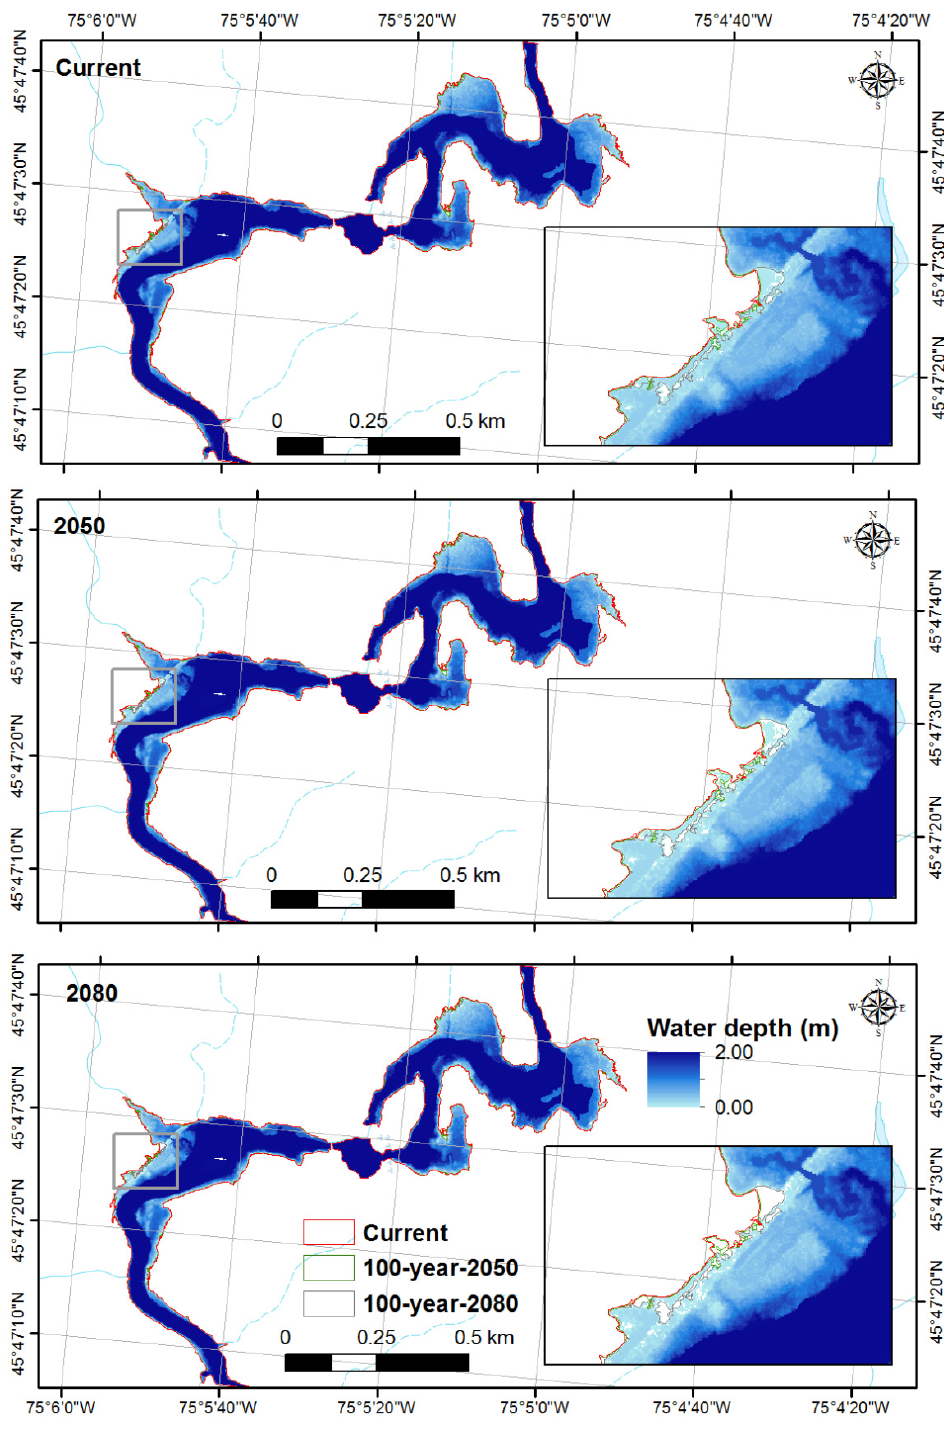
Figure A6. Projected flood depth for a 100-year return period (RCP 8.5). Case: Ripen.